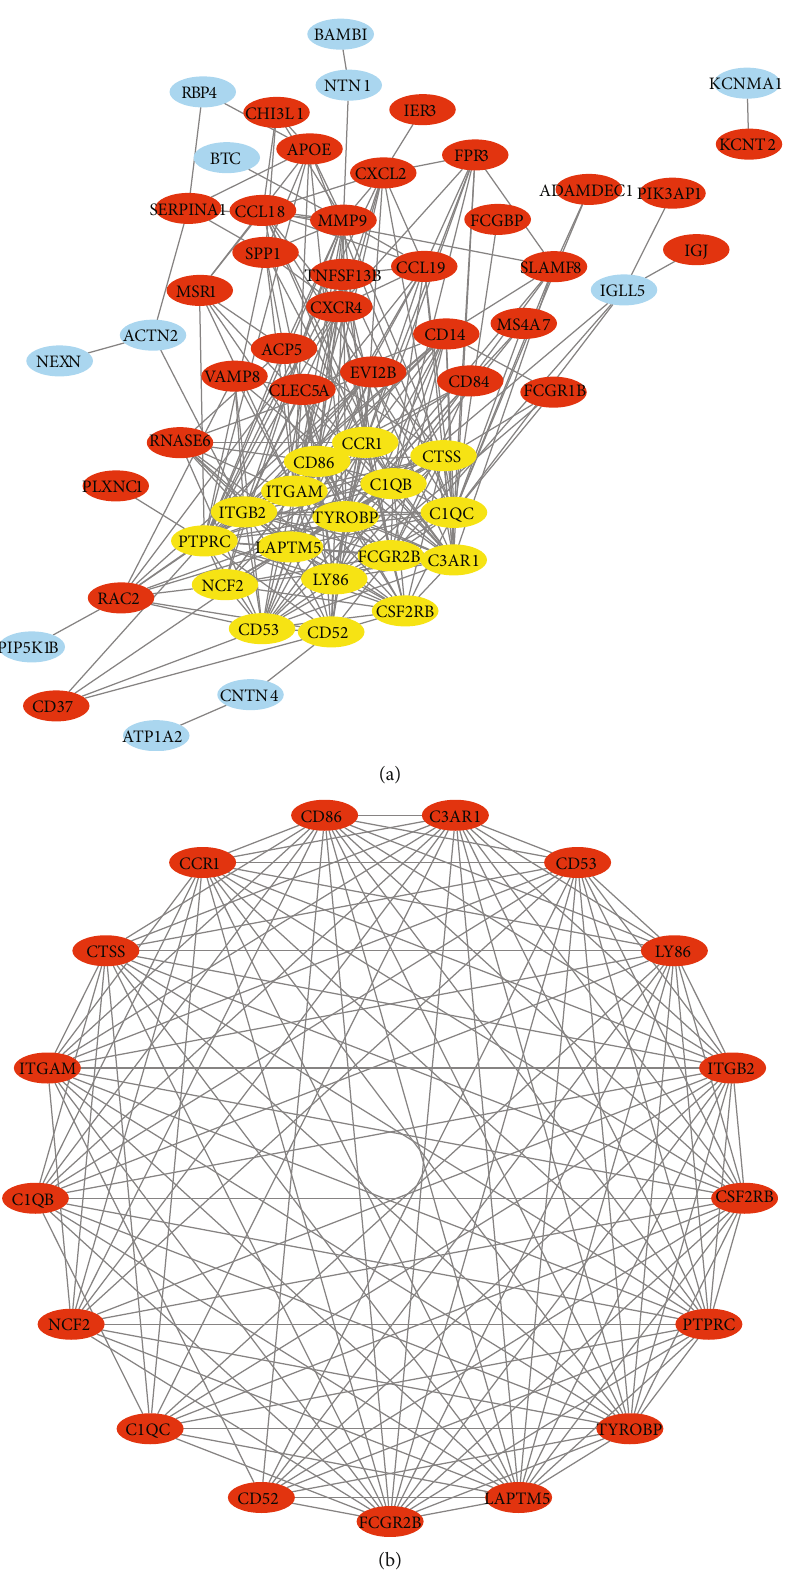
Figure 2: (a) Protein-protein interaction (PPI) networks; red represents upregulated genes, blue represents downregulated genes, and yellow represents the signi fi cant module genes. Analysis was performed with MCODE. (b) Signi fi cant module genes; red represents upregulated module